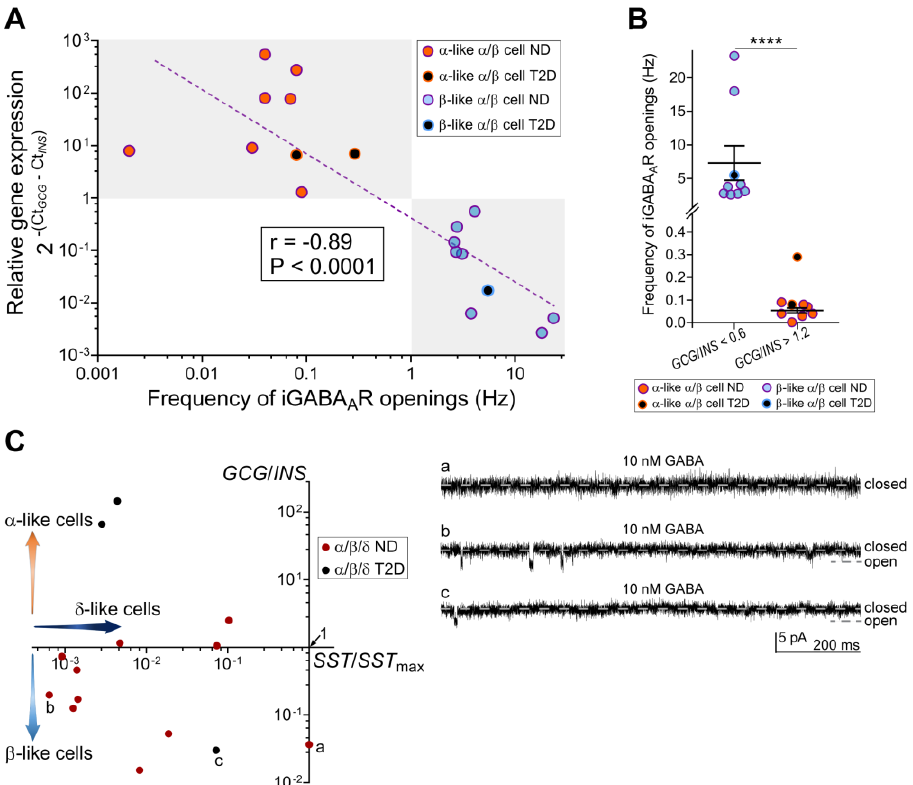
Figure 3. Frequency of single-channel iGABA A R openings in mixed-identity α/β cells and combined data for mixed-identity α/β/δ cells. ( A ) Negative correlation between frequency of single-channel iGABA A R openings and the relative GCG / INS gene expression in individual mixed-identity α/β cells showing that the higher INS expression in the α/β cell (= the more mixed-identity cell is a β-like), the higher frequency of the single-channel iGABA A R openings in such cell. Spearman correlation coefficient r = −0.89, p < 0.0001, n = 18. ( B ) The frequency of single-channel iGABA A R openings in the α/β cells with the GCG / INS ratio between 0.002 and 0.6 (β-like cells, see A) is significantly higher than that in α/β cells with the GCG / INS ratio between 1.2 and 550 (α-like cells, see A). Nonparametric Mann-Whitney test, **** p < 0.0001, n = 9 in the β-like group, n = 8 in the α-like group. The uppermost data point in the α-like group was obtained from T2D donor, detected as outlier by Tukey method and excluded from the comparison. ( C ) Hormone transcript expression levels and the representative iGABA A R-mediated current recordings in individual mixed-identity α/β/δ cells. The hormone transcript expression levels in individual mixed-identity α/β/δ cells presented as the GCG / INS expression ratio in the cell versus the expression of the SST in the same cell normalized to the maximal expression of the SST among all mixed-identity α/β/δ cells ( SST / SST max ). The lower SST / SST max ratio, the more negligible SST component in mixed-identity α/β/δ cell, and then the cell is considered as mixed-identity α/β cell. Thus, to be e.g., β-like, mixed-identity α/β/δ cell should fall into lower left part of the scatter plot (downward arrow). The recordings of iGABA A R-mediated currents were performed from non-diabetic donors ( a , b ) and a type 2 diabetic donor ( c ). Recording ( a ) was obtained from the mixed-identity α/β/δ cell with the SST max . Electrophysiological recordings were done at V h = −70 mV. Pancreatic islets were exposed to 10 nM GABA. Glucose concentration in all experiments was 20 mM.